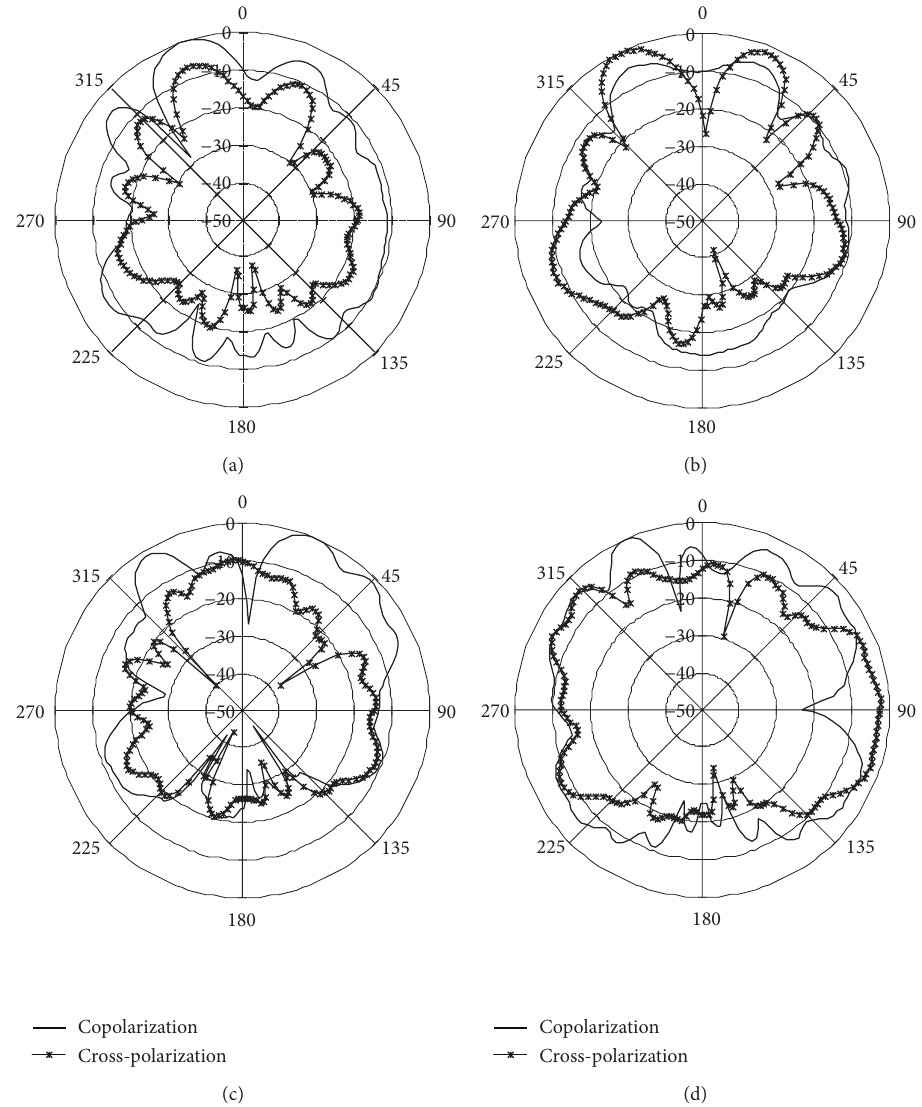
Figure 14: Radiation patterns of the proposed antenna, (a) 11.32 GHz at E-plane, (b) 11.32 at H-plane, (c) 14.96GHz at E-plane, and (d) 14.96 GHz at H-plane.